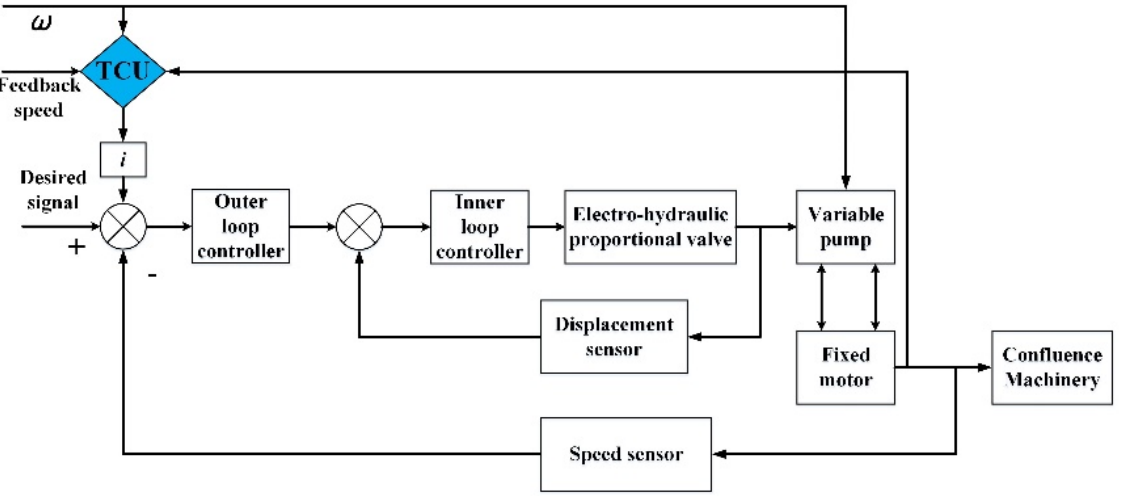
Figure 6. Pump-motor hydraulic control system principle diagram.